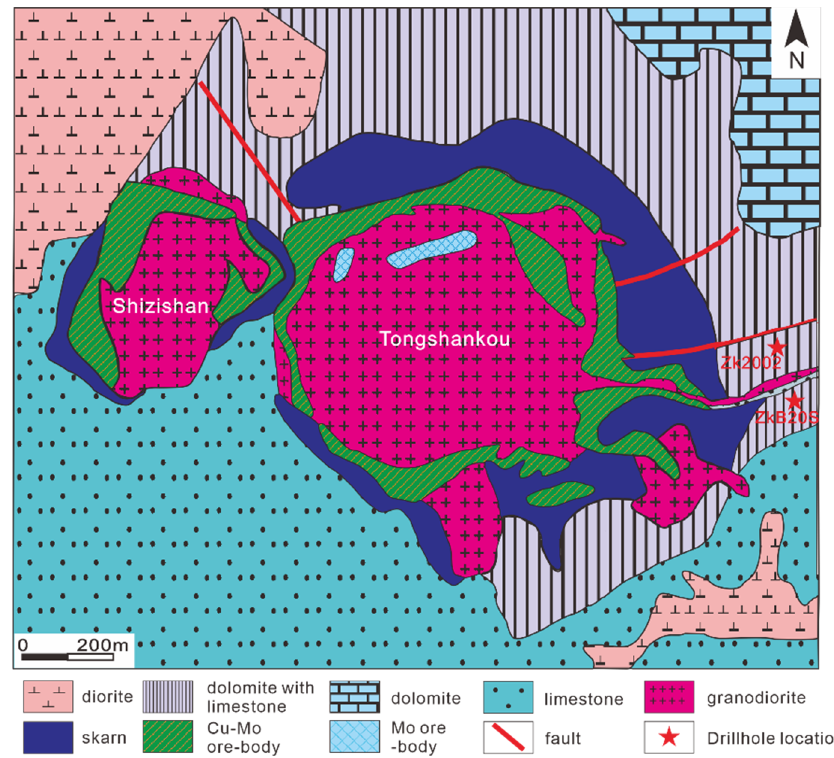
Figure 3. Geologic map of the Tongshankou deposit (simplified from [9]).